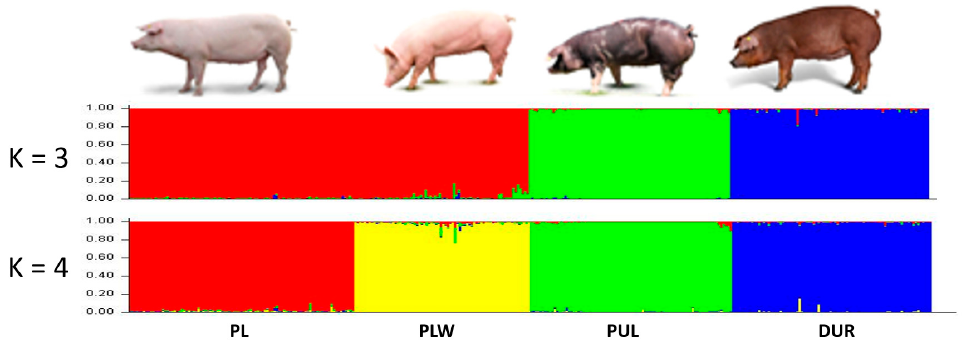
Figure 2. STRUCTURE analysis of 14 STR genotypes from pigs studied. The samples were grouped by the 4 breeds (K = 4). PLW—Polish Large White; PL—Polish Landrace; PUL—Puławska Pig; DUR—Duroc.